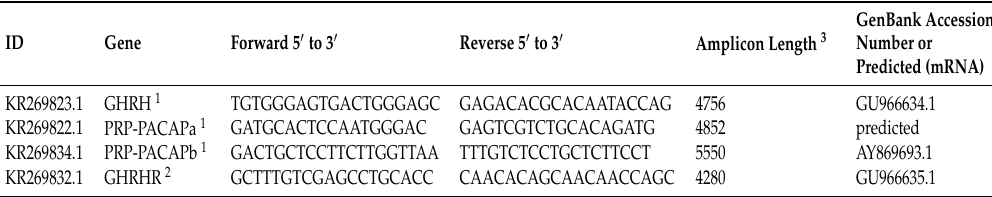
Table 5. Primers of the four genes (four